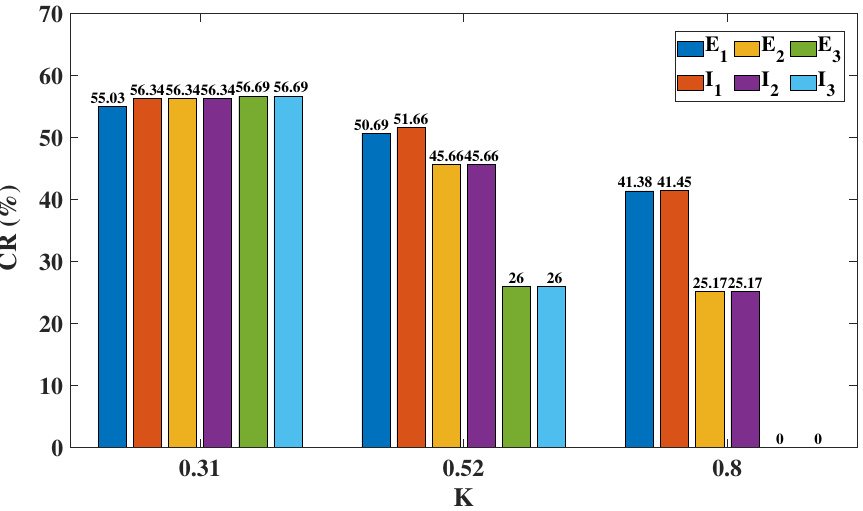
Figure 12. Control rate of the three columns, CR(%), when DBS targets column1. The higher the CR(%) value, the better the control effect. Regardless of the value of K , column1 is well controlled. When K = 0.52, the CR of column2 is slightly reduced, and the CR of column3 is reduced by half. When K = 0.8, column2 also has a significant reduction in CR, and column3 has a zero